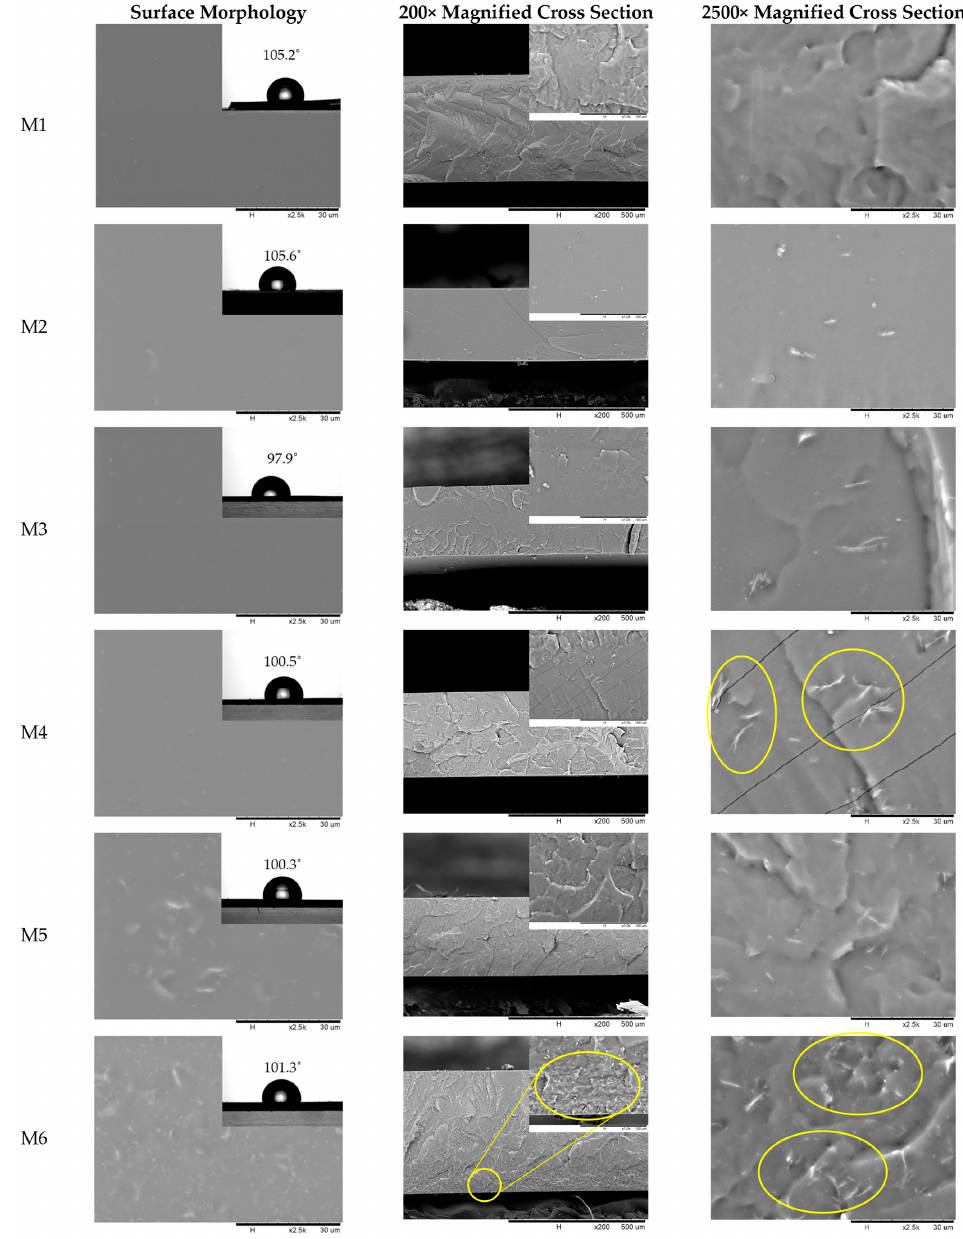
Figure 3. Surface and cross-sectional morphology of PDMS and PDMS/MgO membranes at various loading. The inset of the surface morphology shows the water CA obtained from five average values. the membrane